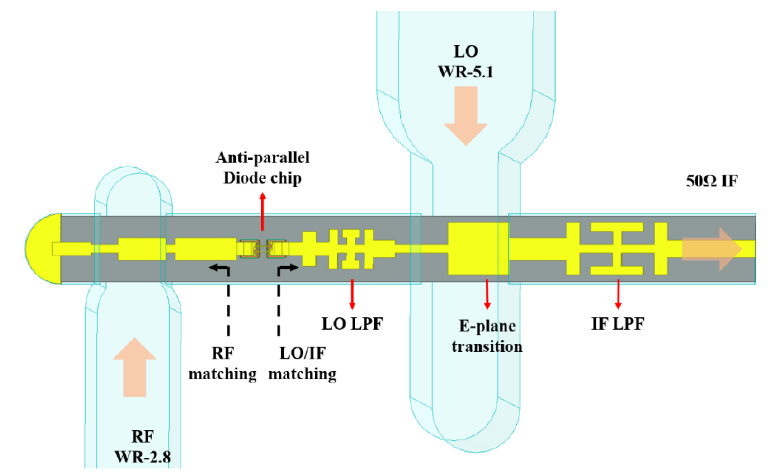
Figure 7. Circuit configuration of the proposed monolithic integrated subharmonic mixer in HFSS.